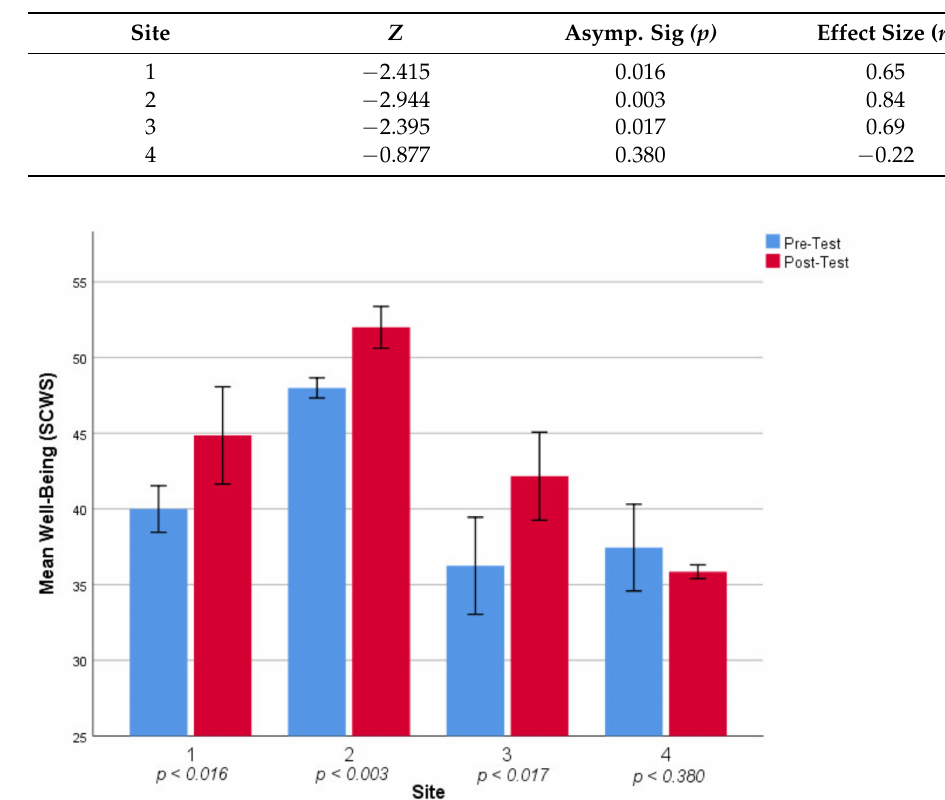
Figure 1. Mean change in participant well-being by